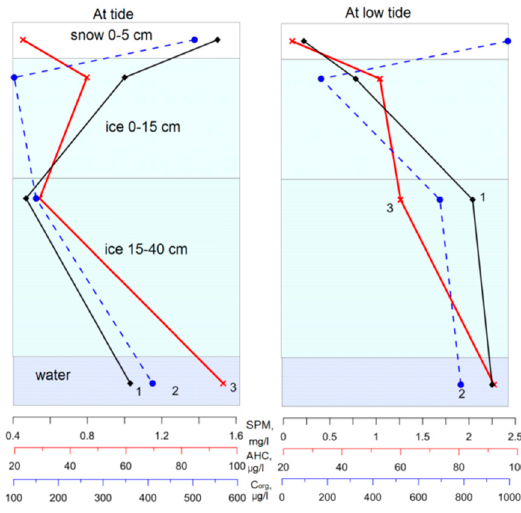
Figure 8. Distribution of the 1—SPM, 2—C org , and 3—AHCs in the snow-ice cover of the Onega River mouth in February 2017.